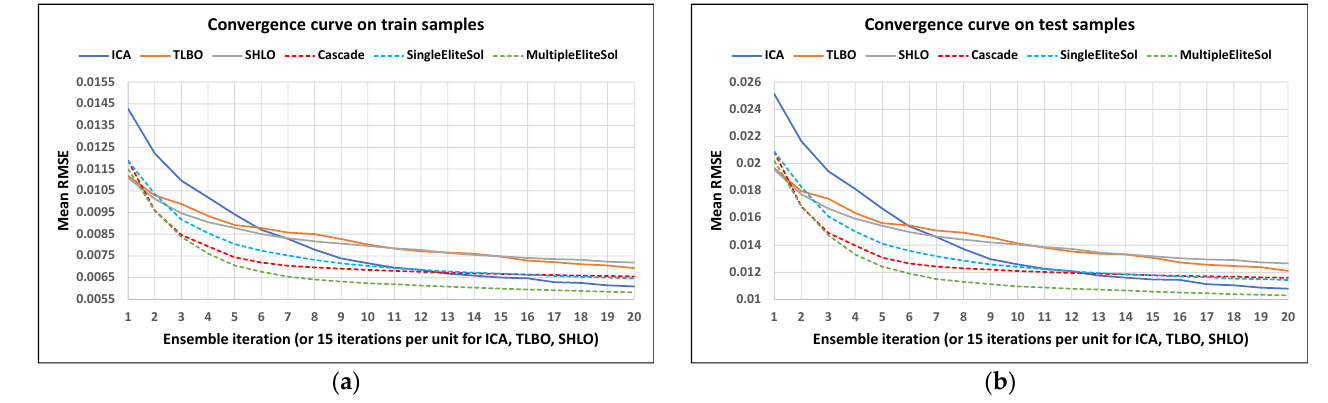
Figure 8. The convergence curve graphs on: ( a ) train samples; ( b ) test samples.